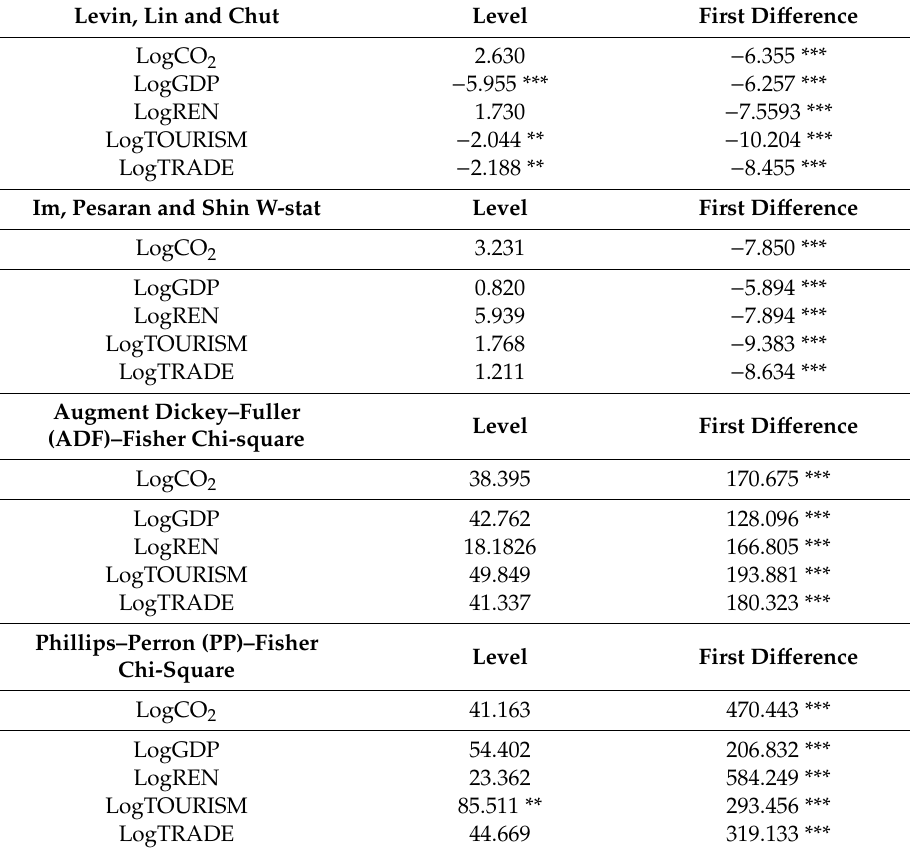
Table 3. Panel Unit Root